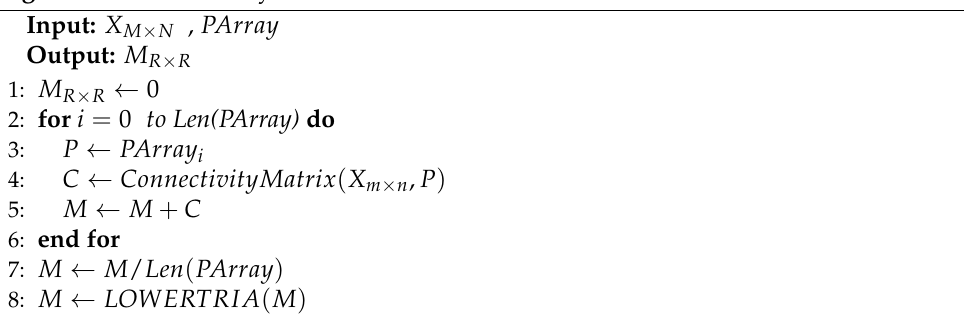
Algorithm 2 Community Matrix